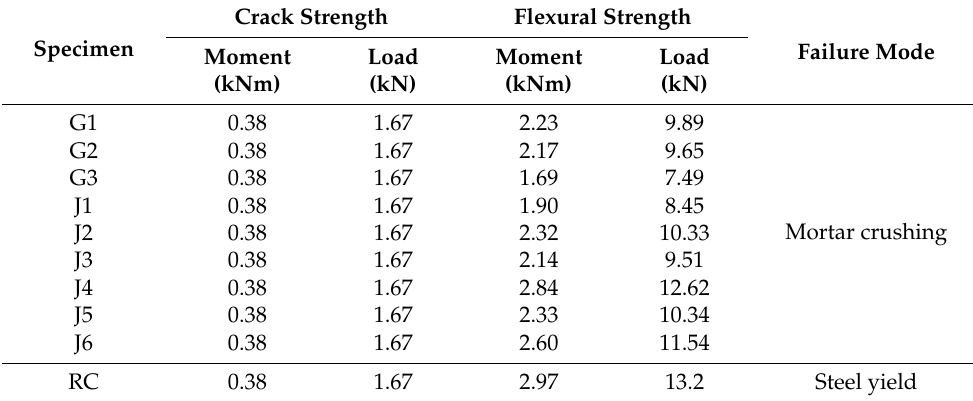
Table 4. Crack and flexural strength results for the